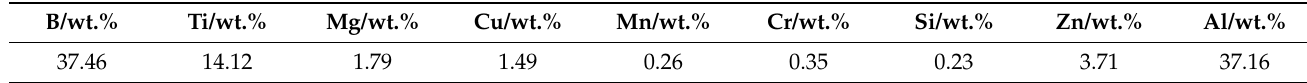
Figure 9. SEM images of second-phase particles and corresponding EDS scanning results. ( a ) SEM Table 3. Second-phase particle composition